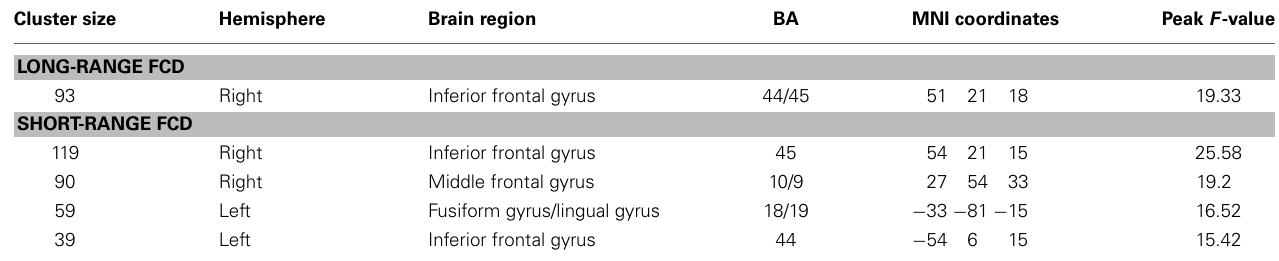
Table 2 | Main effect of the general risk propensity scores on long- and short-range FCD.